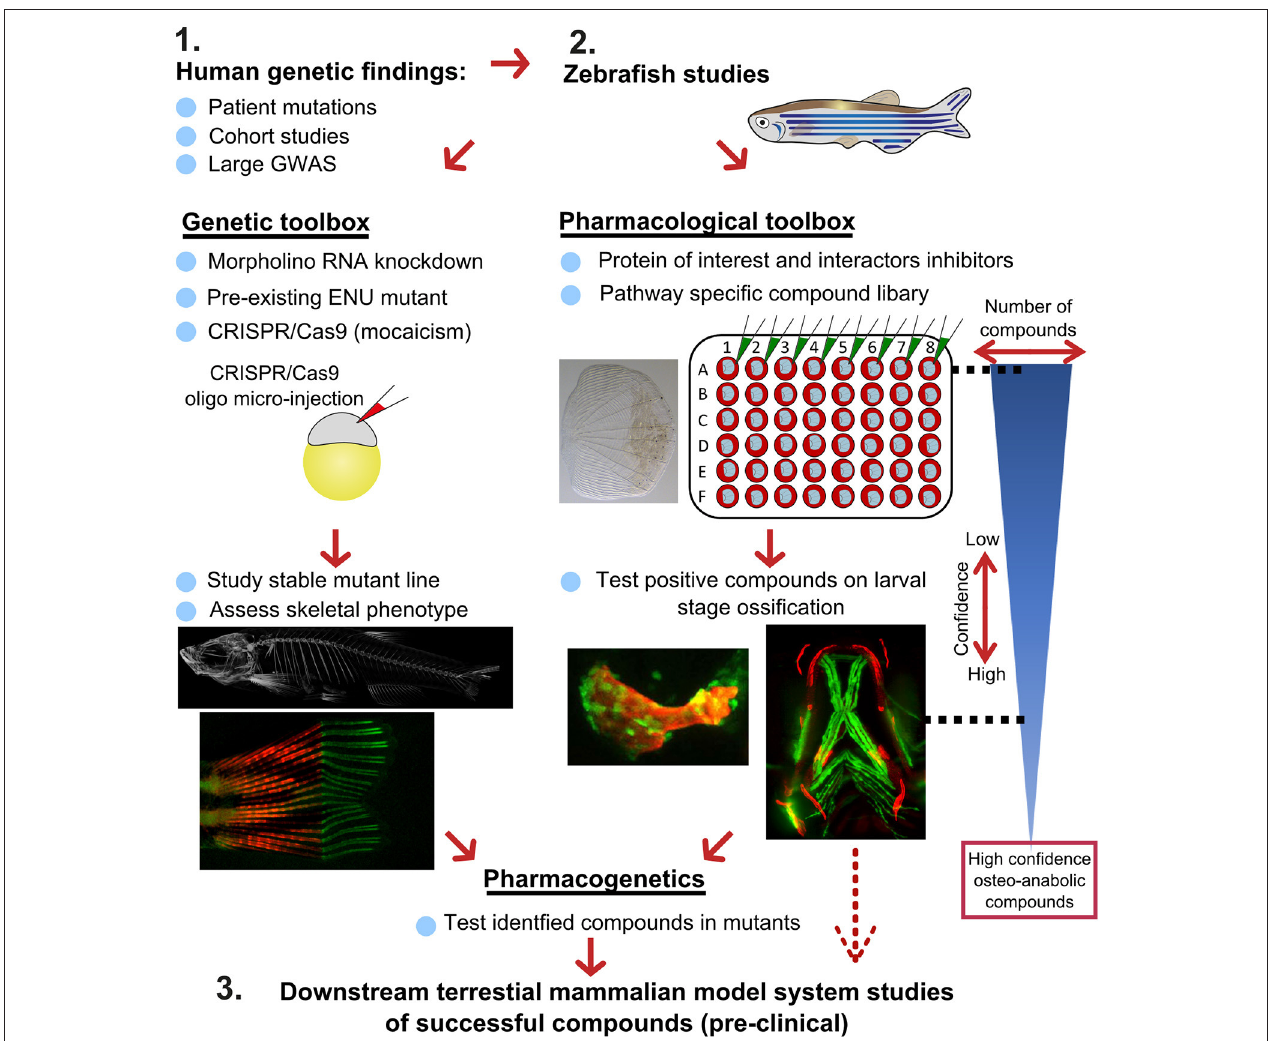
FIGURE 7 | Proposed pipeline using zebrafish as a primary testing platform to address bottleneck for fast and affordable translation of human genetic findings. Two experimental arms using the genetic and pharmacological toolboxes allow simultaneous drug target validation. The blue reversed triangle depicts the reduction in number of putative osteo-anabolic compounds (along with an increase in confidence) when testing the compounds using the skeletal assays